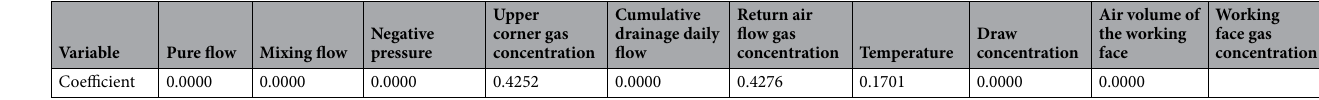
Table 4. Variable coefficients after lasso feature